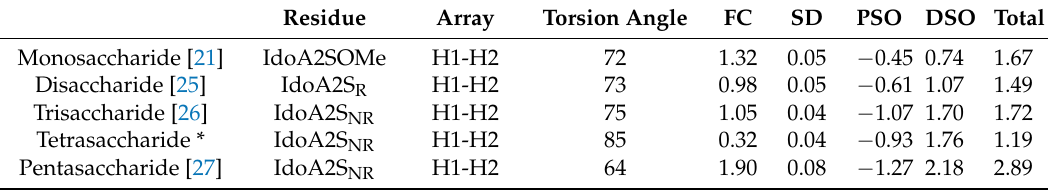
Table 7. DFT–computed (B3LYP/6-311+(d,p)) Fermi contact, spin–dipolar, paramagnetic spin–orbit and diamagnetic spin–orbit contributions to three–bond H1–H2 proton–proton coupling constants (values in Hz) in monosaccharide IdoA2SOMe and in other structurally similar heparin–like oligosaccharides. Total 3 J H-C-C-H magnitudes are listed in the final